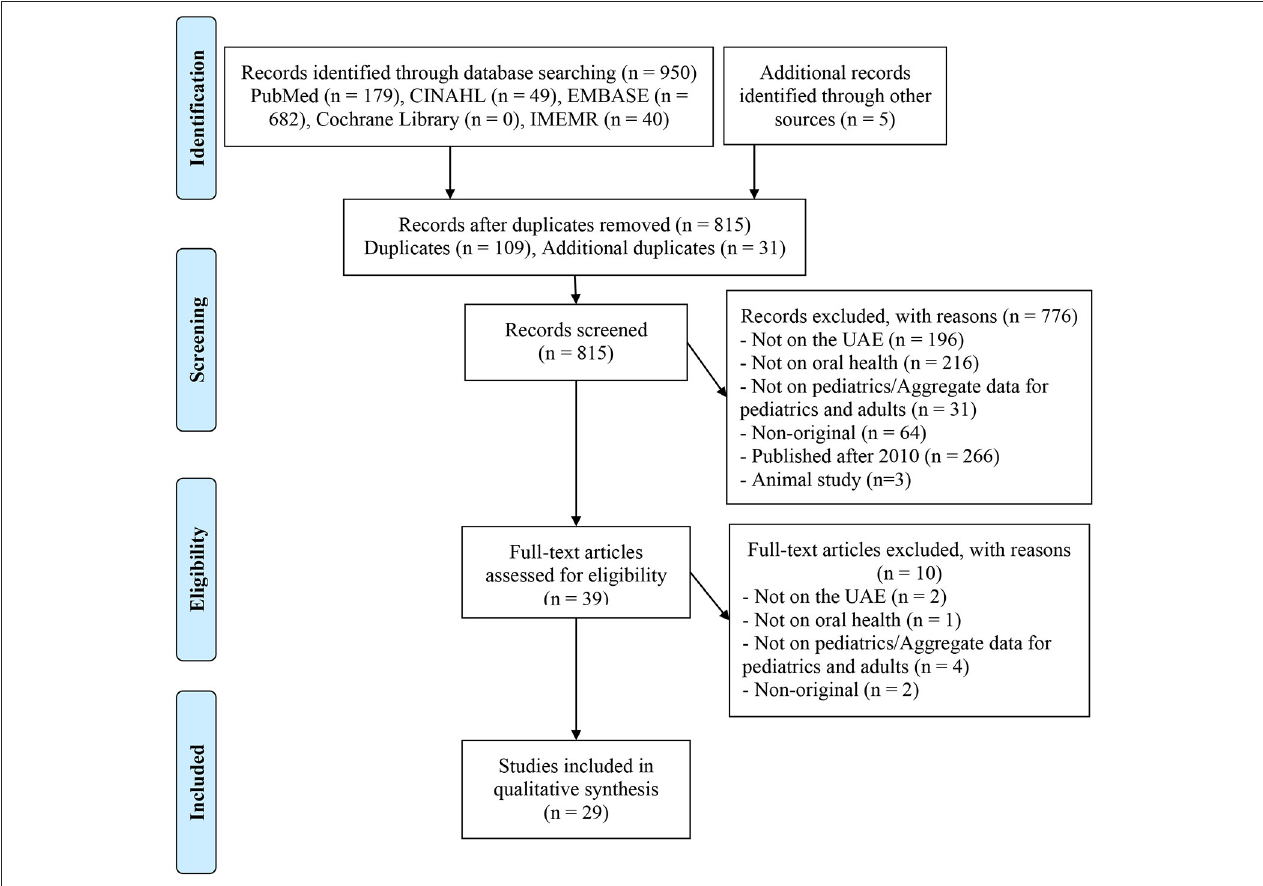
FIGURE 1 | PRISMA diagram of study